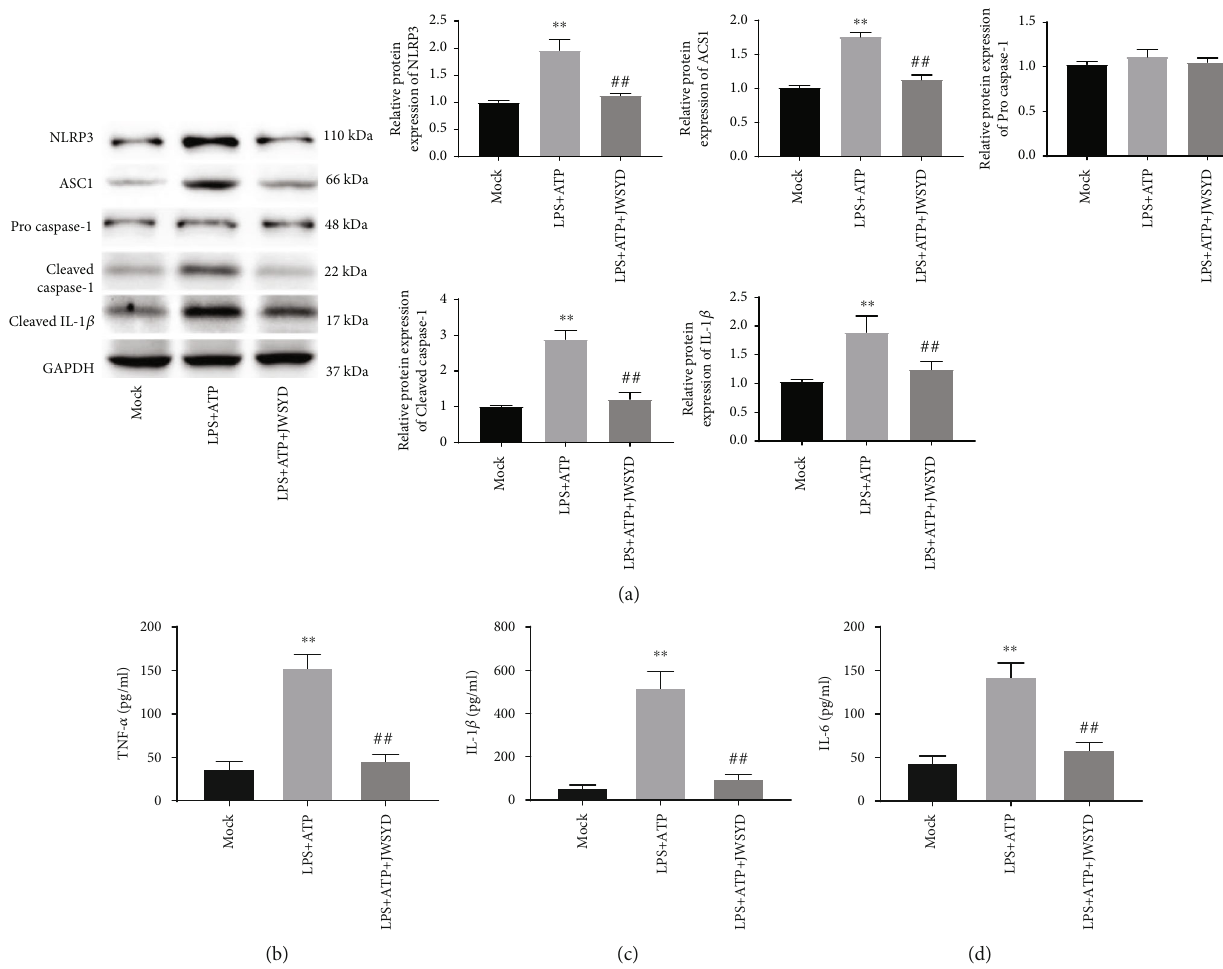
Figure 4: Jiaweishaoyao decoction (JWSYD) inhibited the in fl ammatory reaction in LPS-induced RAW264.7 cells. (a) Protein levels of NLRP3 in fl ammasome-associated proteins (NLRP3, ASC1, Procaspase-1, Cleaved caspase-1, and Cleaved IL-1 β ) in LPS-induced RAW264.7 cells. (b – d) The levels of TNF- α , IL-1 β , and IL-6 were detected by ELISA in RAW264.7 cell supernatants. ∗∗ P < 0 : 01 compared with the mock group; ## P < 0 : 01 compared with the LPS+ATP